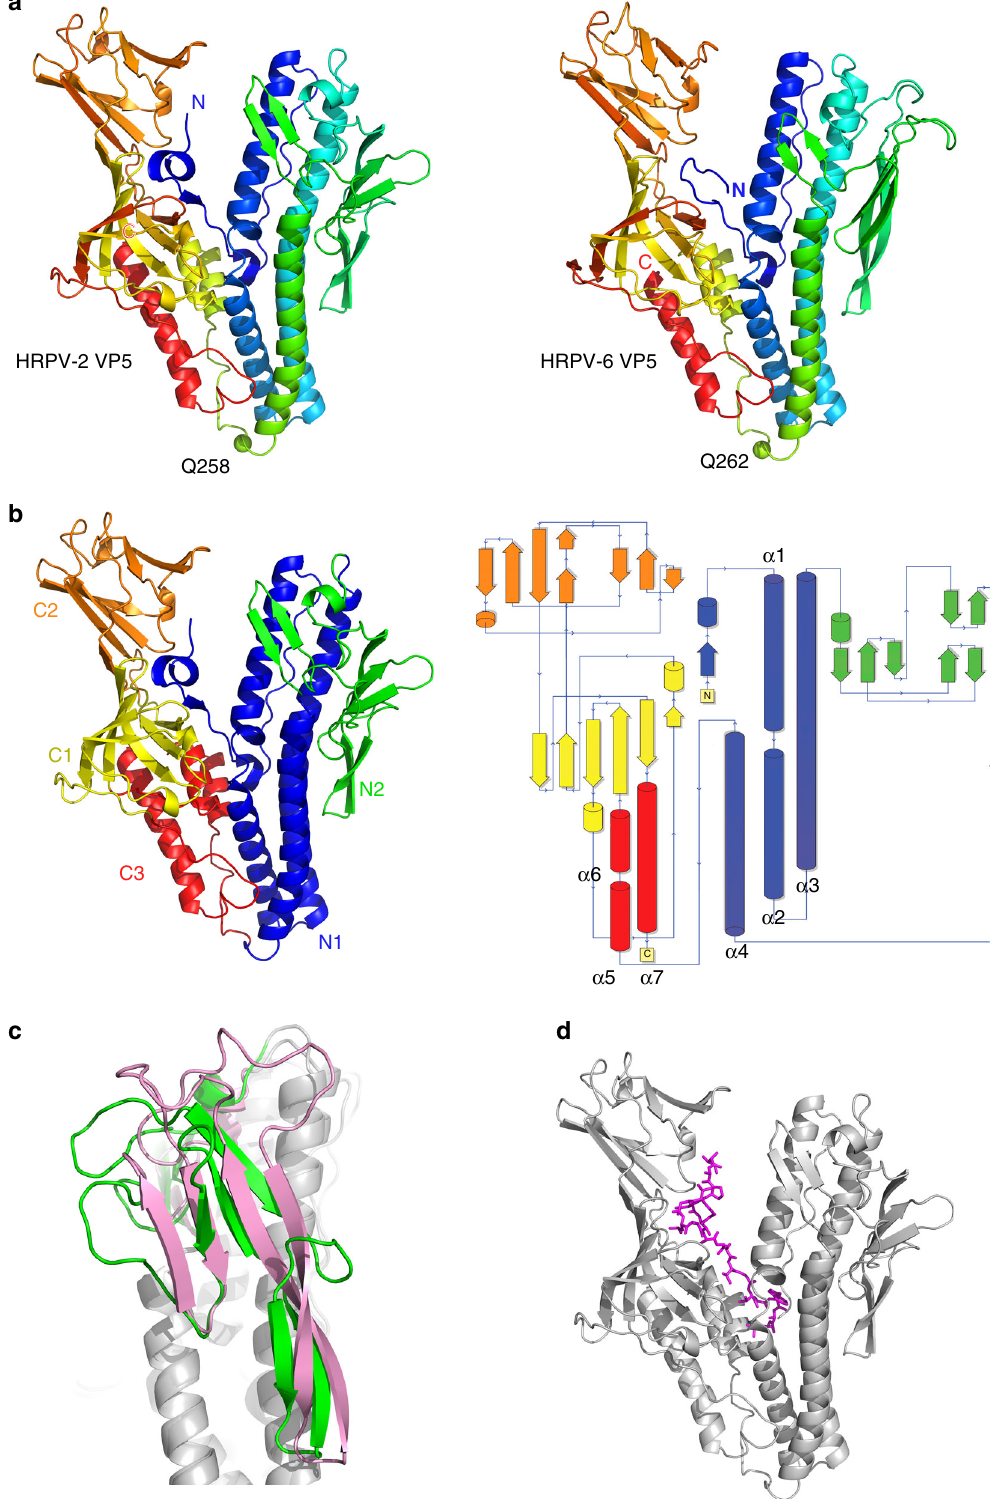
Fig. 1 The overall fold of VP5. a Cartoon representation of HRPV-2 VP5 (left) and HRPV-6 VP5 (right) coloured from the N-terminal (blue) to the C- terminal (red). Residues Q258 and Q262 connecting the N- and C-terminal domains are shown as green spheres. b Cartoon and topology representation of HRPV-2 VP5 coloured by domains. c Structural differences between the N2 domains of superposed HRPV-2 VP5 (green) and HRPV-6 VP5 (pink). d Localization of the potential fusion peptide depicted as magenta sticks within HRPV-2 VP5 shown as grey